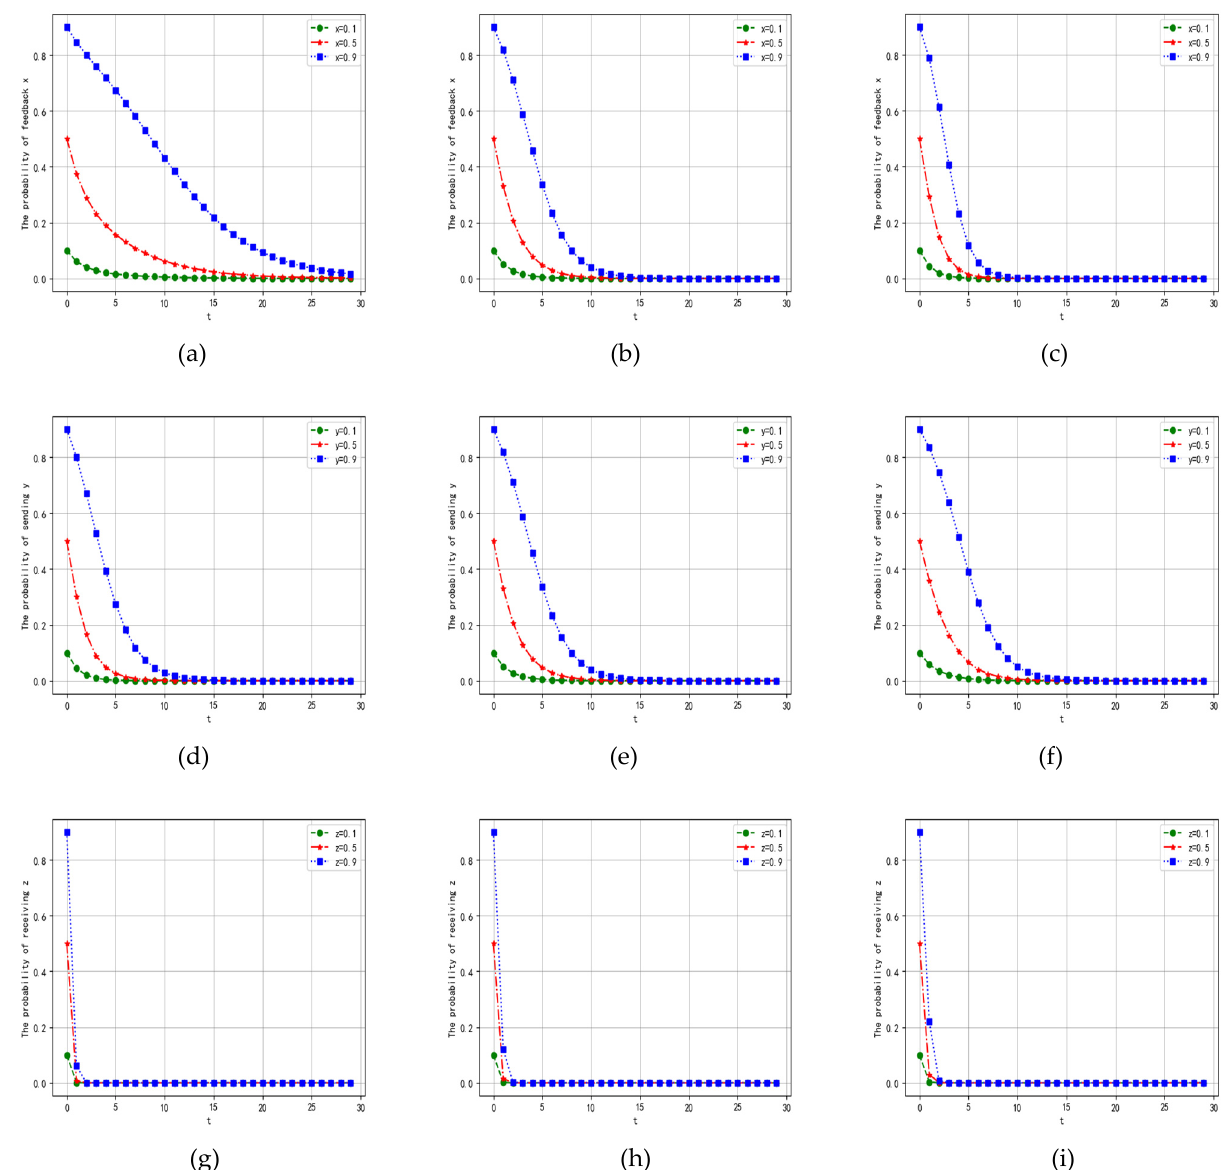
Figure 10. Evolutionary results of λ shown under different probabilities of strategy. λ is 0.2, 0.5, and 0.8, from left to right. ( a – c ) show that the probability of strategy x changes when time t is under the different conditions of λ = 0.2, 0.5, and 0.8. ( d – f ) show that the probability of strategy y changes when time t is under the different conditions of λ = 0.2, 0.5, and 0.8. ( g – i ) show that the probability of strategy z changes when time t is under the different conditions of λ = 0.2, 0.5, and 0.8. Figure 11 elucidates the impact of parameter α on evolutionary results under different agents in the multi-agent system. The other parameters are assumed as follows: λ = 0.5, β = 0.2, γ = 0.1, p = 0.5, R f = 20, C f = 5, P L 1 = 20, P L 2 = 10, C L 1 = 3, C L 2 = 1, R L = 20, C L =